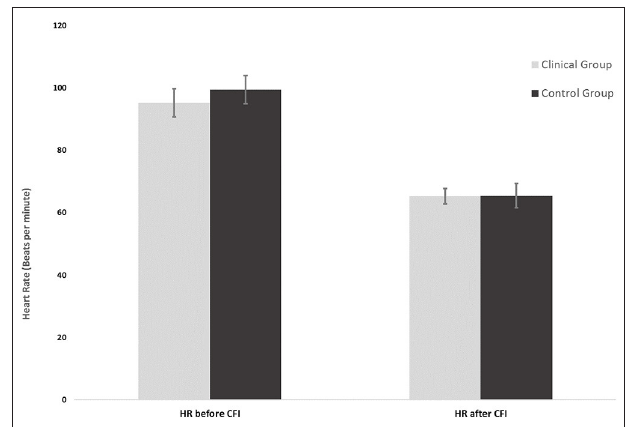
FIGURE 1 | Mean heart rates of the clinical group ( n = 16) and control group ( n = 16) before and after CFI.